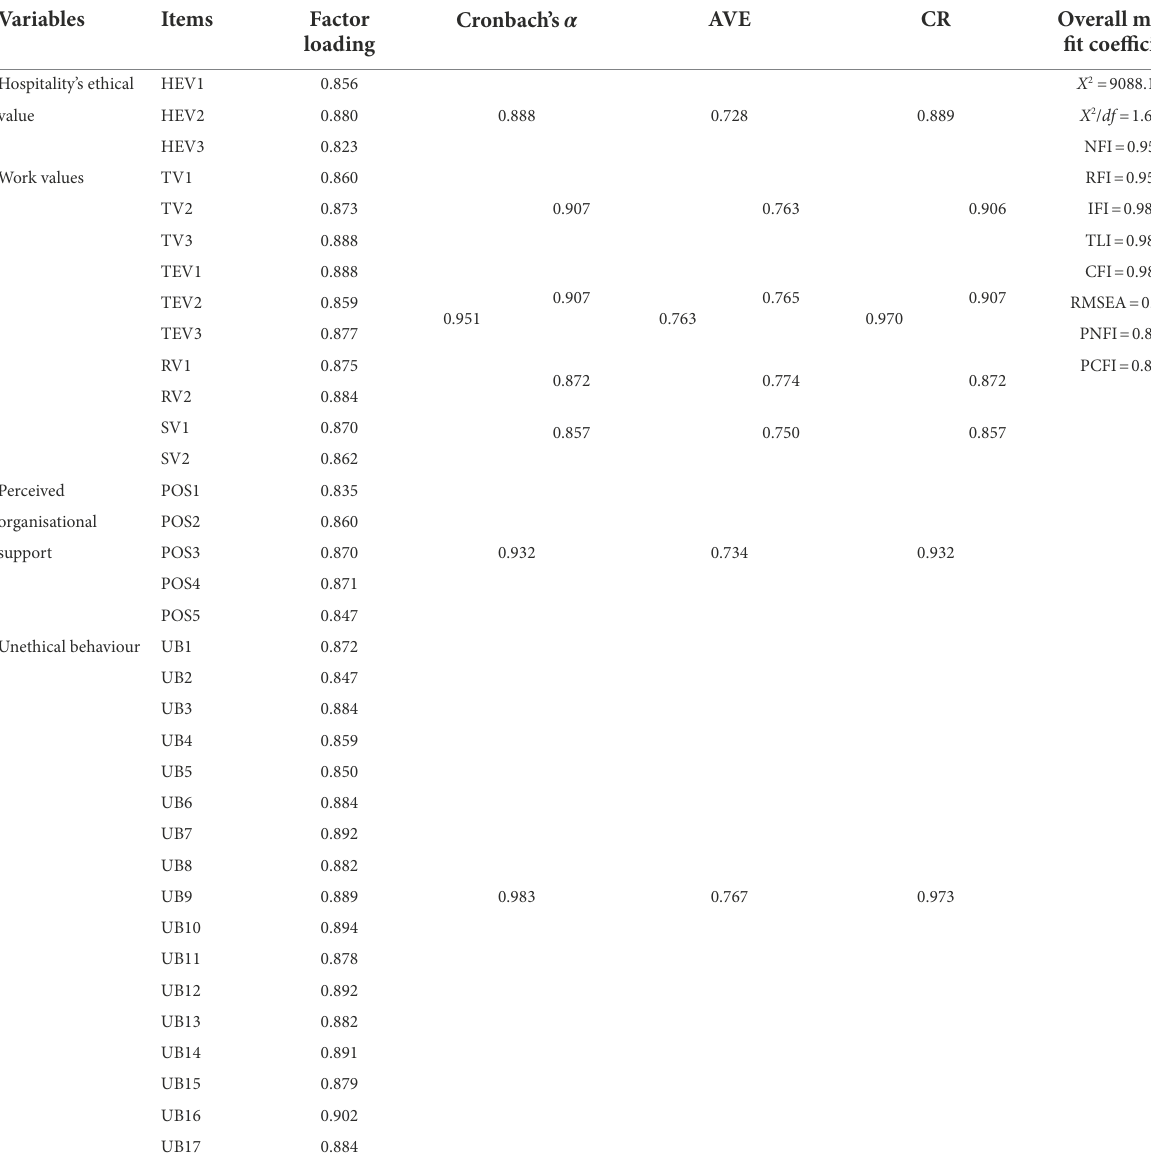
TABLE 2 Descriptive statistics and confirmatory factor